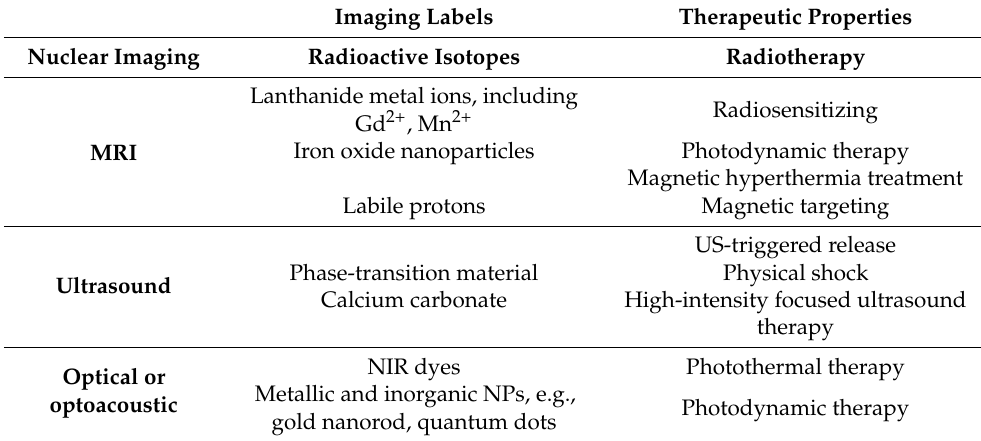
Table 2. Imaging labels and their potential therapeutic properties.